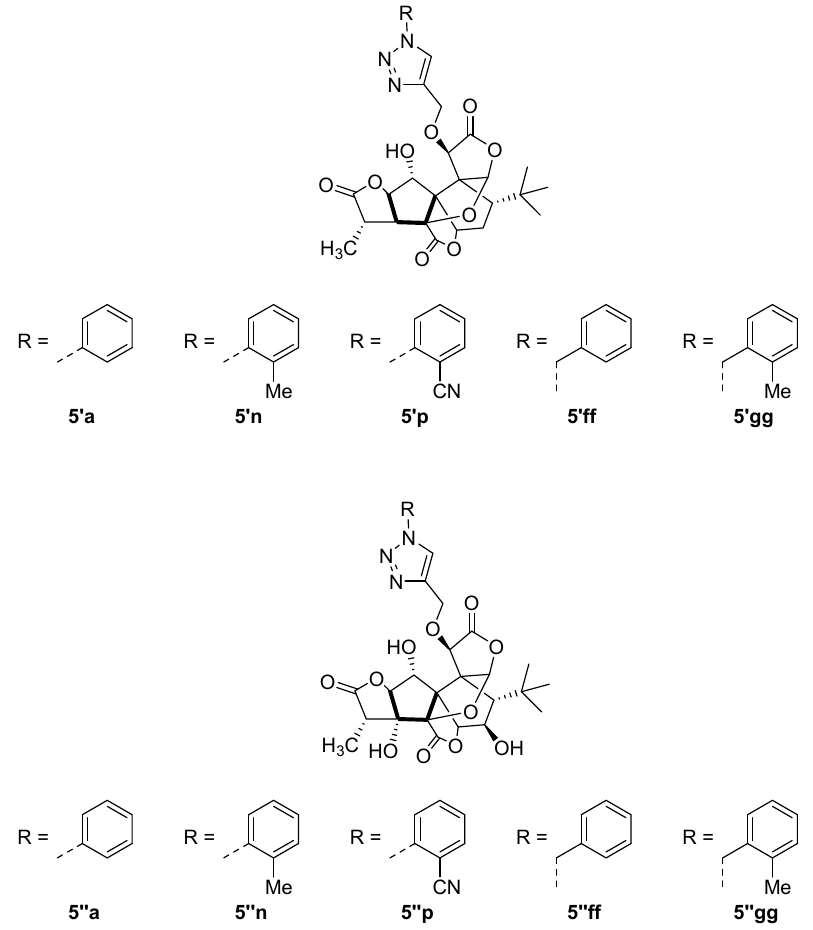
Figure2. Structures of10-substituted1,2,3-triazole-ginkgolideAderivatives 5 (cid:48) a - 5 (cid:48) gg Figure 2. Structures of 10-substituted 1,2,3-triazole-ginkgolide A derivatives 5’a - 5’gg and 10- substituted 1,2,3-triazole-ginkgolide C derivatives 5’’a - 5’’gg .